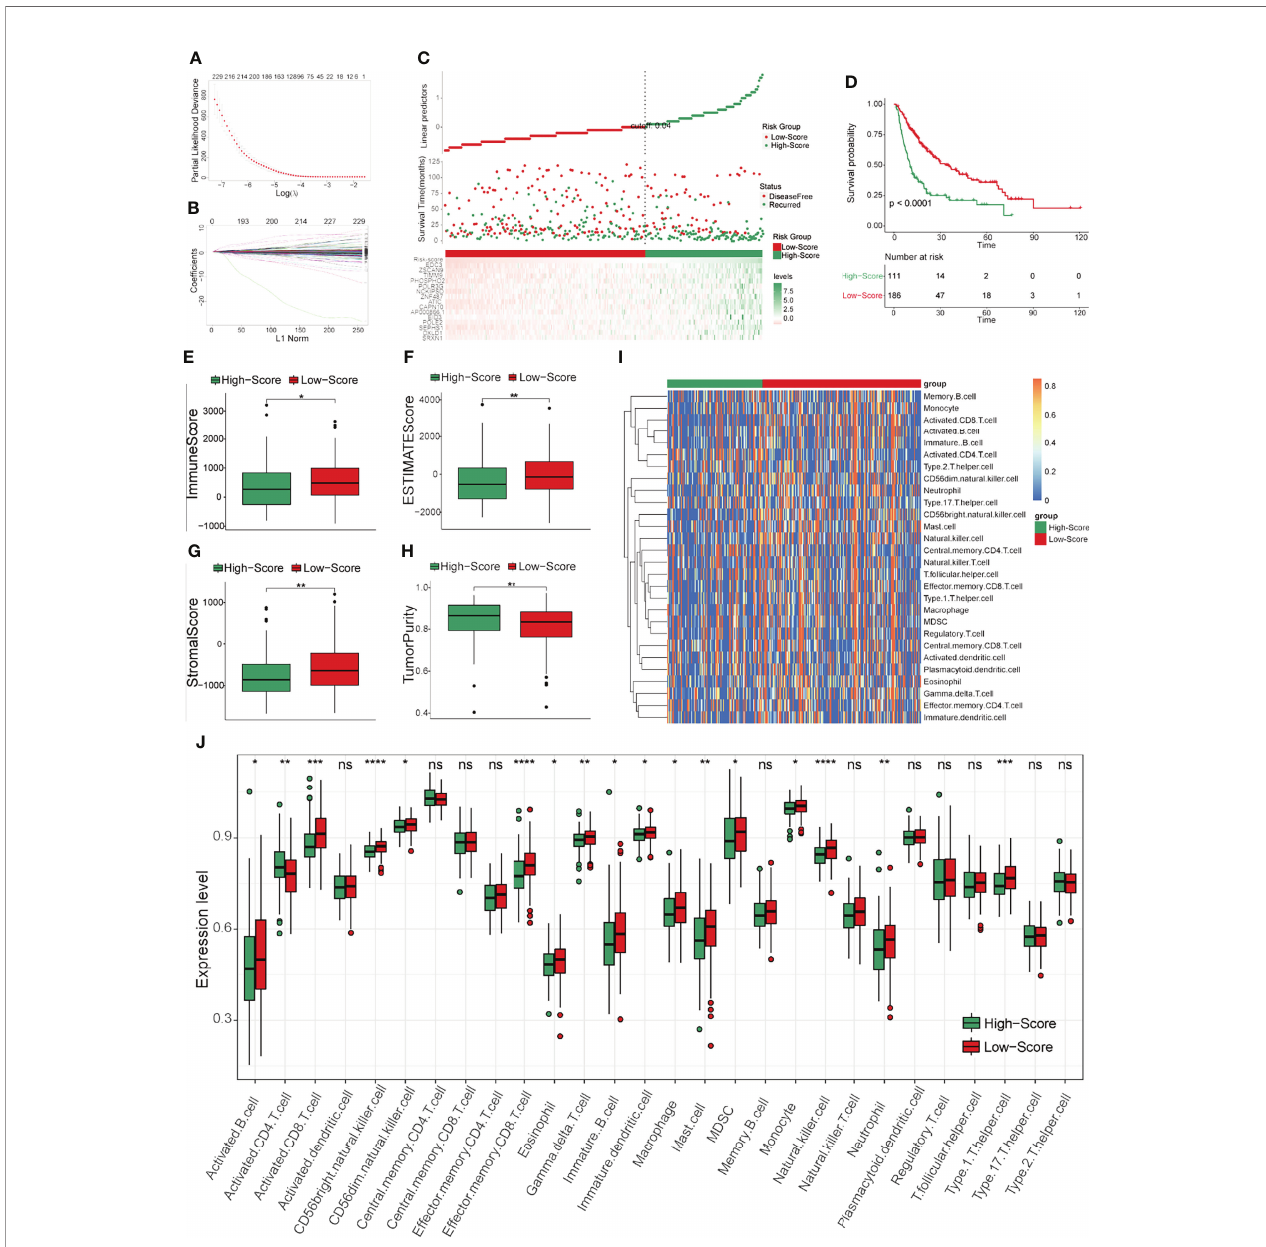
FIGURE 7 | Construction and evaluation of GRS in the training cohort. (A, B) Cv fi t and fi t plots of LASSO screen. (C) Survival status and the expression levels of fi fteen genes in the high- and low-score groups separated by GRS. (D) Kaplan-Meier curve for the two groups in the training cohort. (E – H) The expression levels of the immune score (E) , ESTIMATE score (F) , stromal score (G) and tumor purity (H) in the two groups. (I, J) The expression levels of 28 immune cells in the two groups visualized by heatmap (I) or boxplot (J) . *p < 0.05, **p < 0.01, ***p < 0.001, ****p < 0.0001, ns: not signi fi